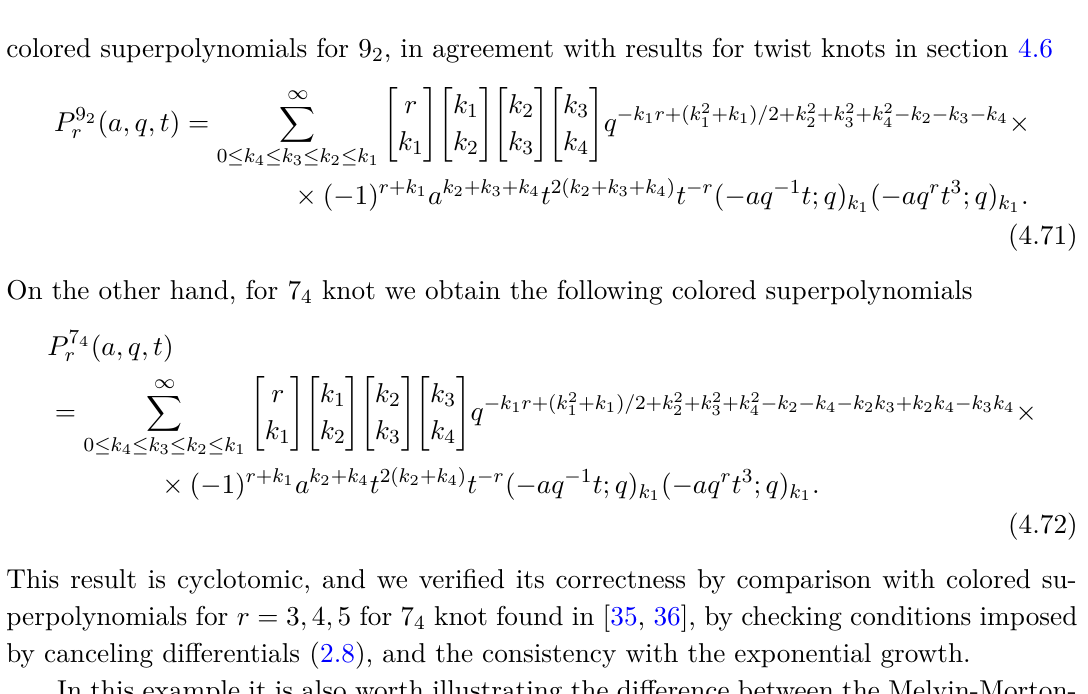
Figure 8 . Homological diagram for 7 4 (left) and 9 2 (right)